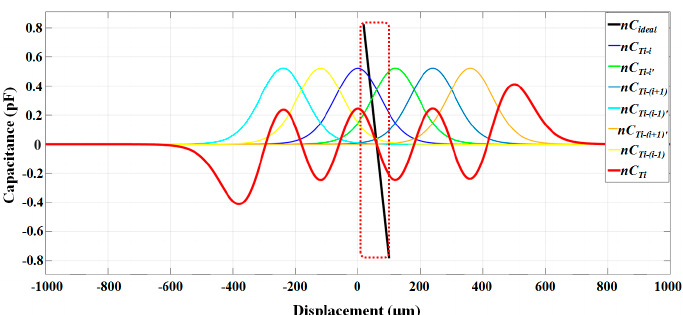
Figure 4. Calculation of the capacitance between electrode T i on the proof mass and 6 nearest electrodes on the top die considering the fringe effect. The capacitor spacing was set as 120 μ m. C ideal (black line) is the theoretical output using an ideal plane-parallel capacitor model. C T output considering the fringe effect, which is the total contribution of C T C T , C . The number of capacitors is Ti − ( i + 1 ) (cid:48) i − i − 1